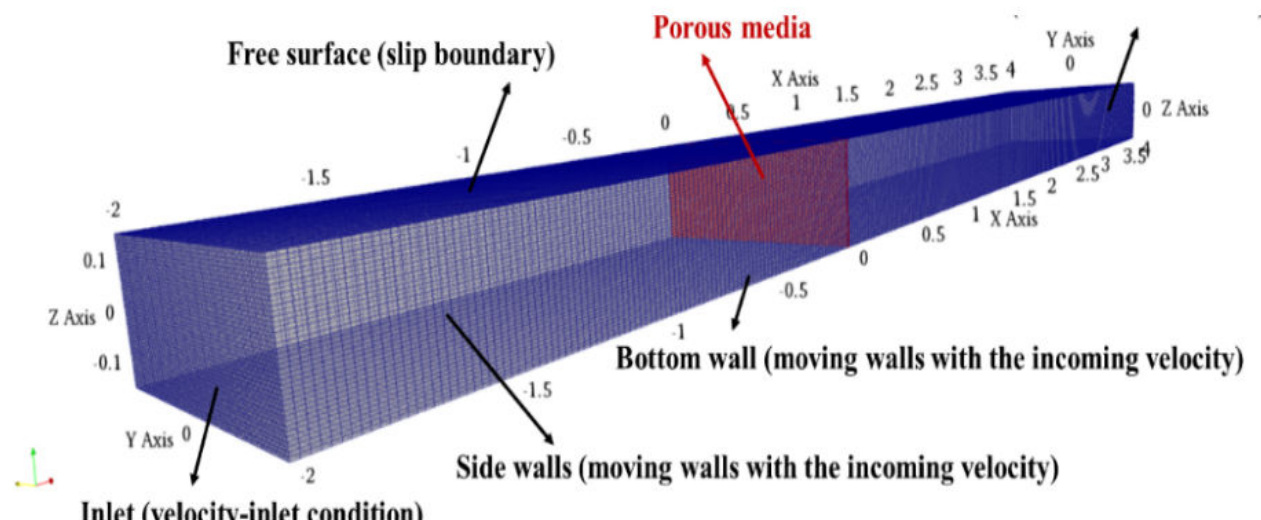
Figure 1. Computational domain with structured grids and boundary